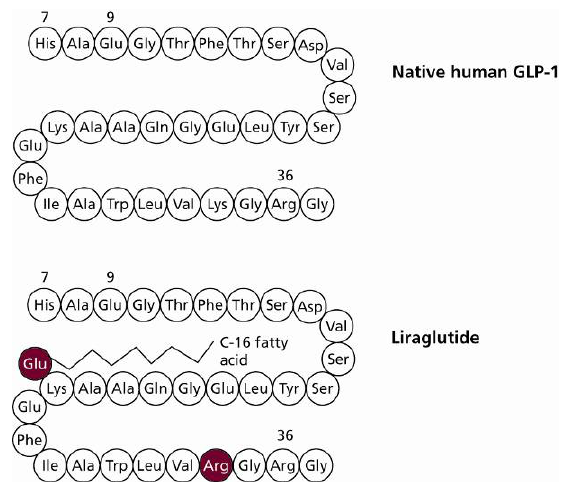
Figure 5. Amino Acid Structure of Native Human GLP-1 and